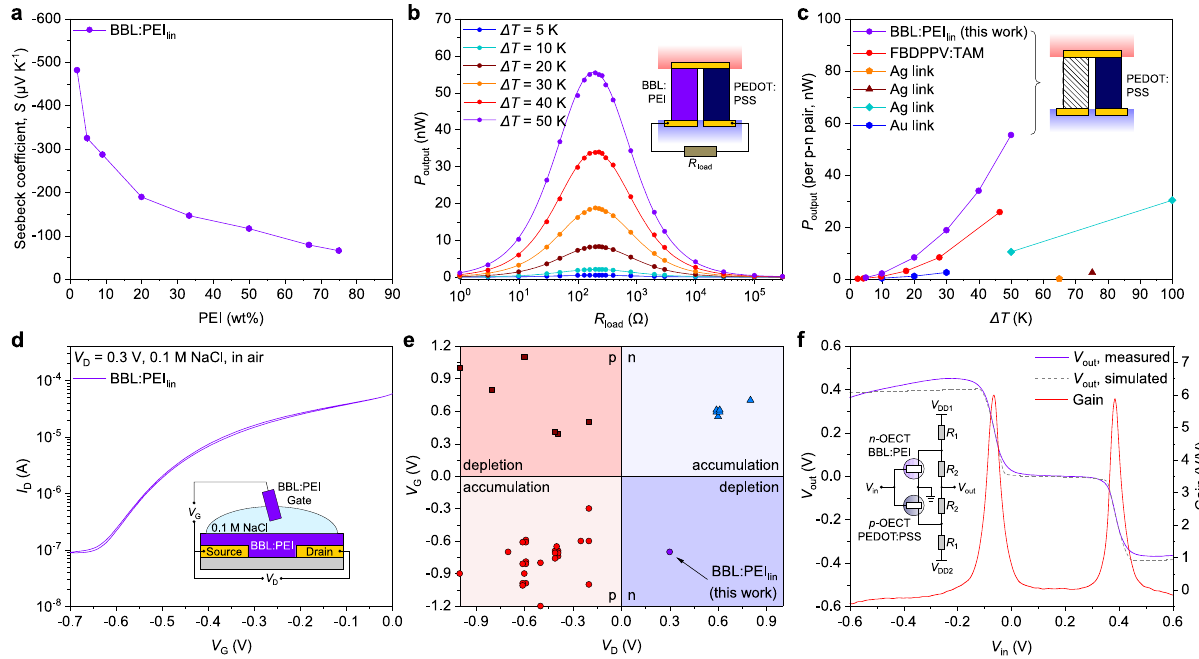
Fig. 5 Applications. a Seebeck coef fi cient of BBL:PEI lin . b Power output vs. resistance loads recorded at different temperature gradients for a